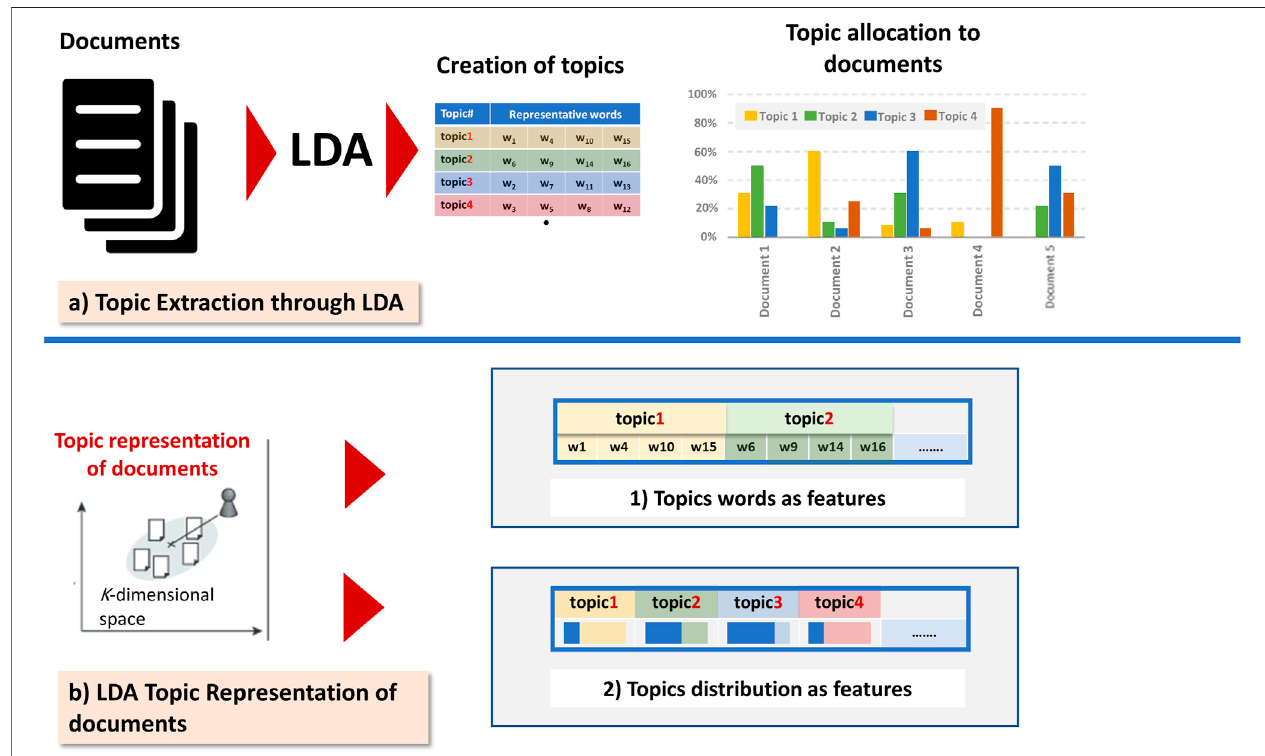
FIGURE 1 | The two commonly utilized LDA representation schemes (topics words as features and topics distributions as features).